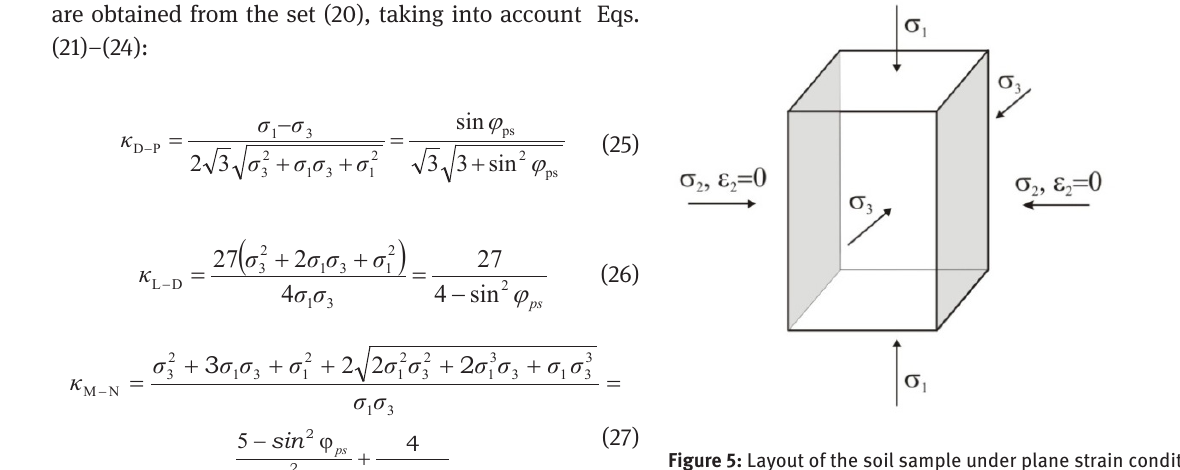
Figure 5: Layout of the soil sample under plane strain conditions in EMTTA.